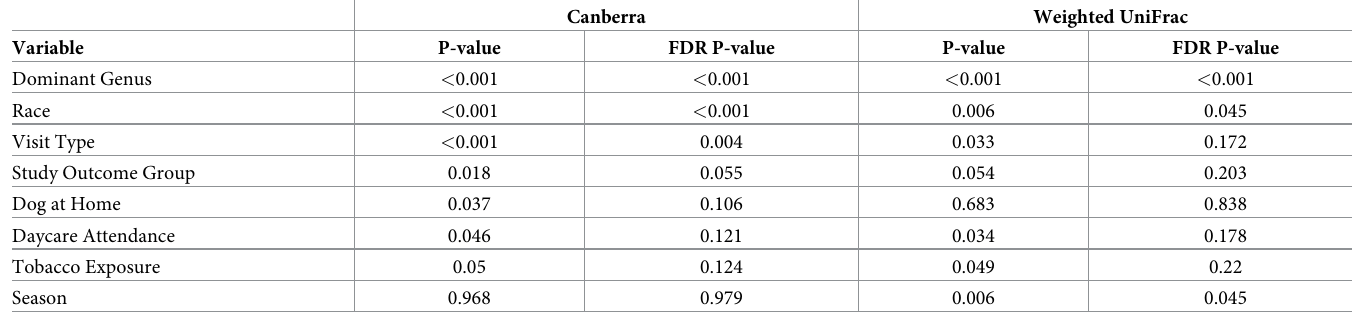
Table 2. Microbiological, clinical and viral factors associated with principal coordinate 1 of a Canberra and Weighted UniFrac distance matrix.